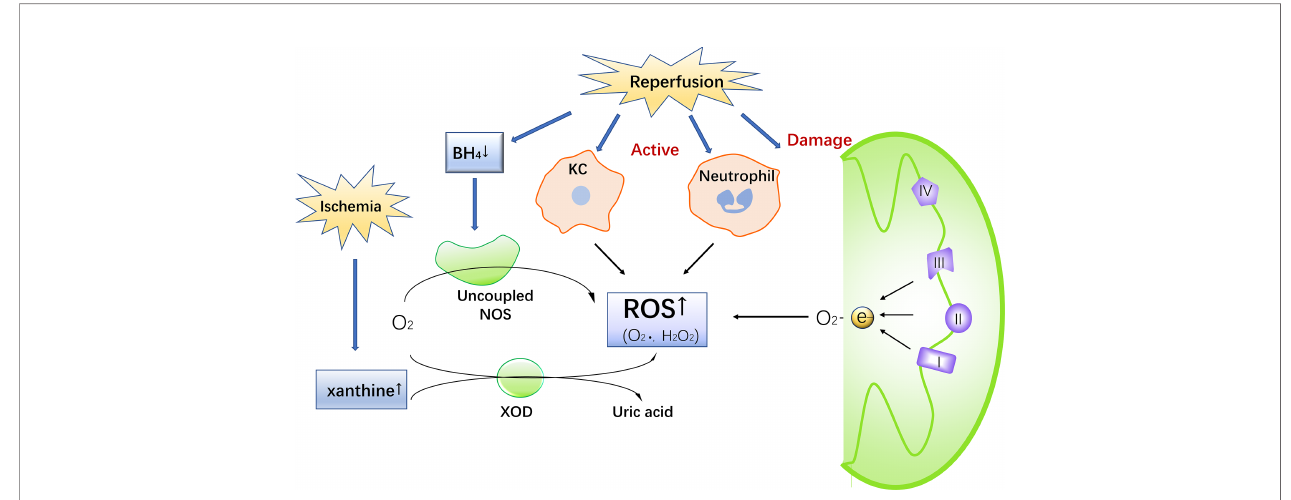
FIGURE 1 | The Production of ROS during IR injury. Ischemia leads to an increase in xanthine. Reperfusion damages mitochondria, activates Kupffer cells and neutrophils, consumes BH4 and uncouples NOS, promotes ROS production, and simultaneous increase of xanthine in the catalysis of xanthine oxidase to produce